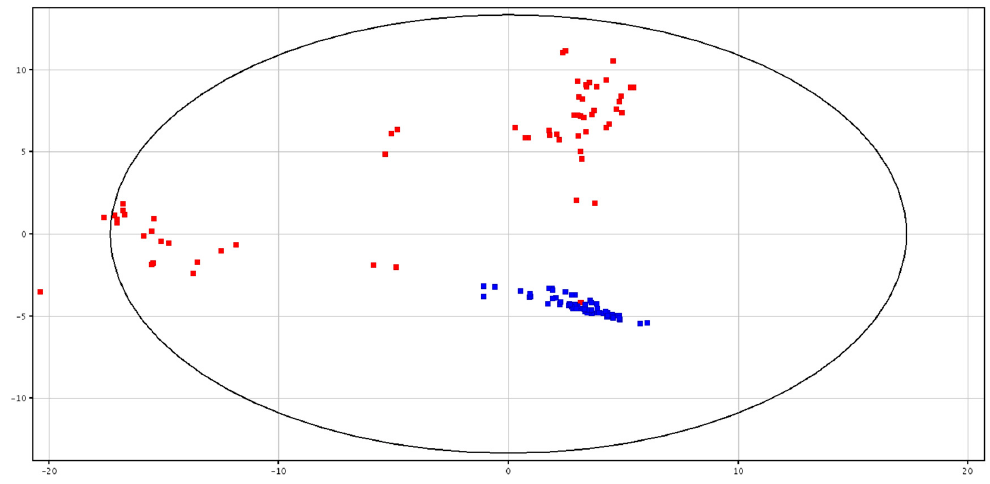
Figure 1. PCA scores plots of the LC–MS data acquired for fresh (in blue; F-P) and cryopreserved (in red; CRY-P) seminal plasma. PC1 ( x -axis) is 37.3%; PC2 ( y -axis) is 22.22%.